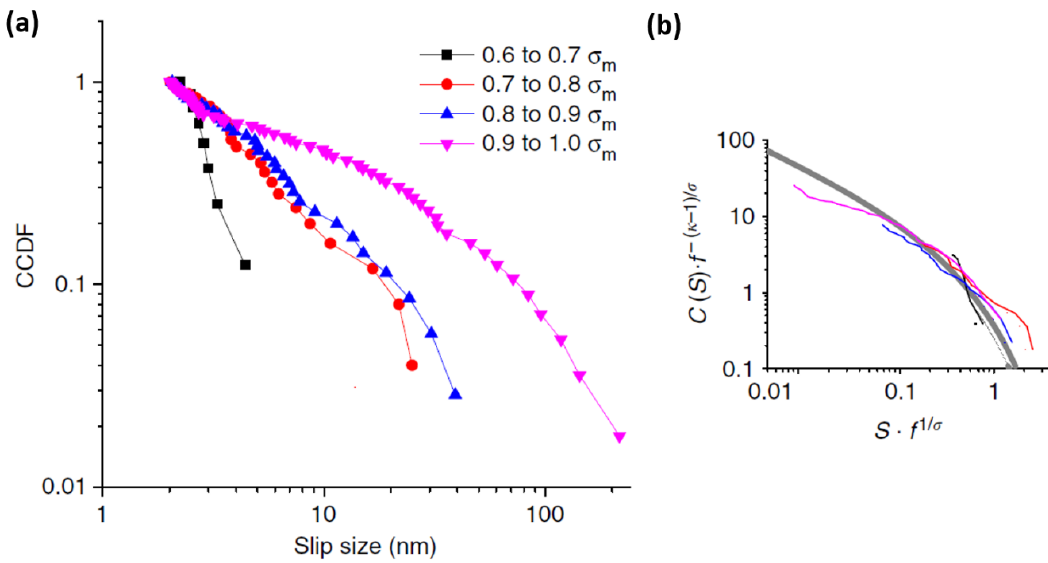
Figure 25. ( a ) The plots of the stress-binned CCDF of slip sizes as a function of the stress level over the maximum stress samples with diameters ranging from ~512 to 655 nm, compressed at a strain rate of 1 × 10 − 3 s − 1 and with similar load–displacement characteristic. ( b ) The scaling collapse of the same data with the predicted scaling function (reproduced from Reference [160]).